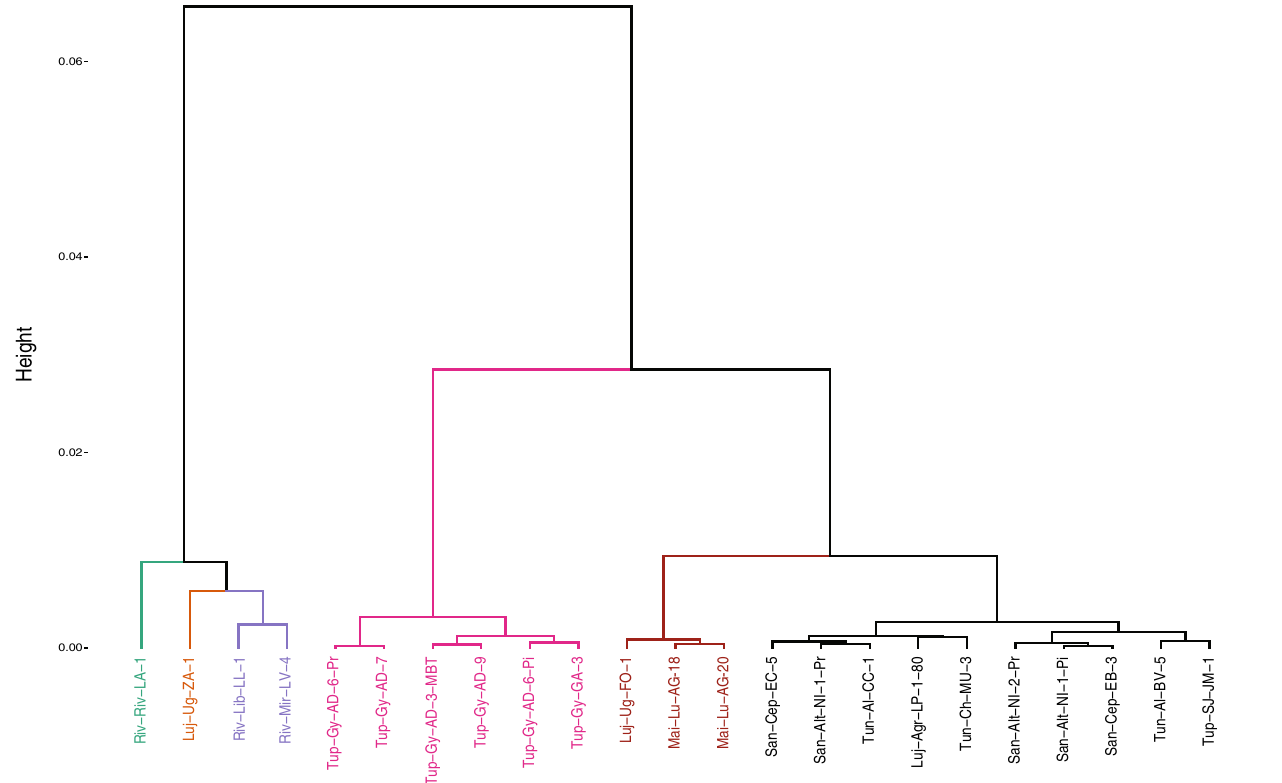
Figure 5. Cluster analysis with data from 23 Malbec parcels by using concentrations of PCs from three vintages (2016, 2017, and 2018). The figure was generated using Adobe Illustrator, version 22.1.0 (https ://www.adobe .com/produ cts/illus trato r.html) and R-package factoextra and R-package